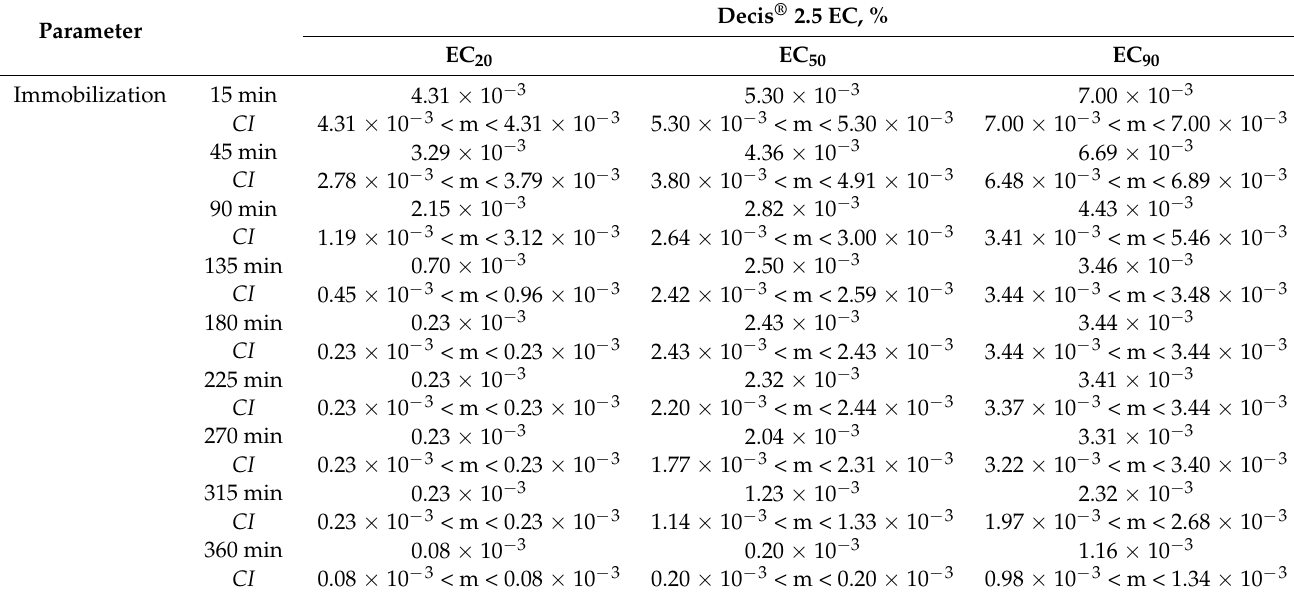
Table 3. Effect of Decis ® 2.5 EC on immobilization of Daphnia magna. The table contains the mean (m) and 95% confidence intervals ( CIs ) for mean.